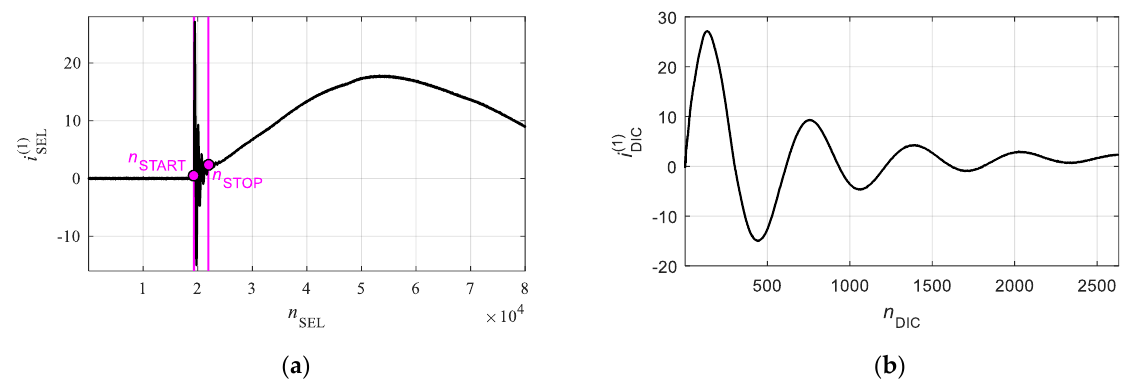
i Figure 8. Current vectors for the sample measurement data: i SEL ( a ) and i DIC ( b SEL